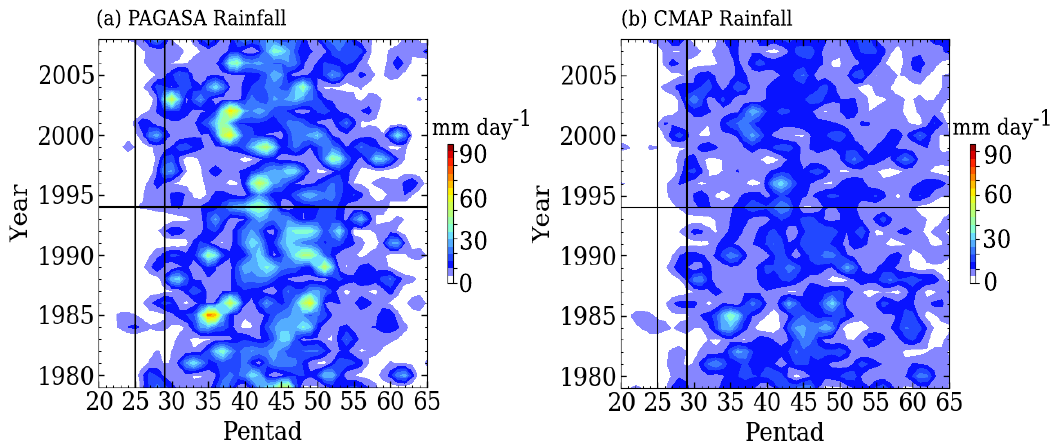
Figure 2. Rainfall distribution (mm day − 1 ) from 1979–2008 averaged across the: ( a ) seven PAGASA stations; and ( b ) five nearest CMAP grid points to the PAGASA stations. The rainfall distributions are smoothed by 1–2–1 filter in both x- and y -axis. The two vertical lines in ( a , b ) indicates P25 (start of May) and P29 (climatological onset based on Akasaka [7]), respectively. The horizontal line in ( a , b ) indicates